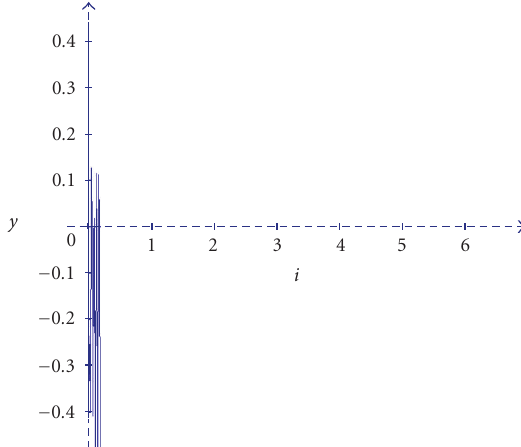
Figure 6.23 . Unstable solution of (5.1) in the point A (520,100), a 0 = 0 . 438.